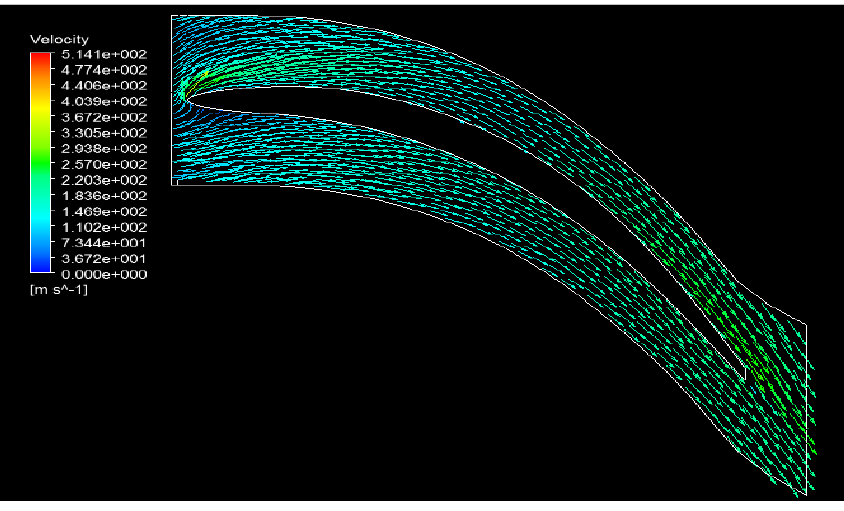
Figure 33. CFD study results: Velocity mid-spam detail